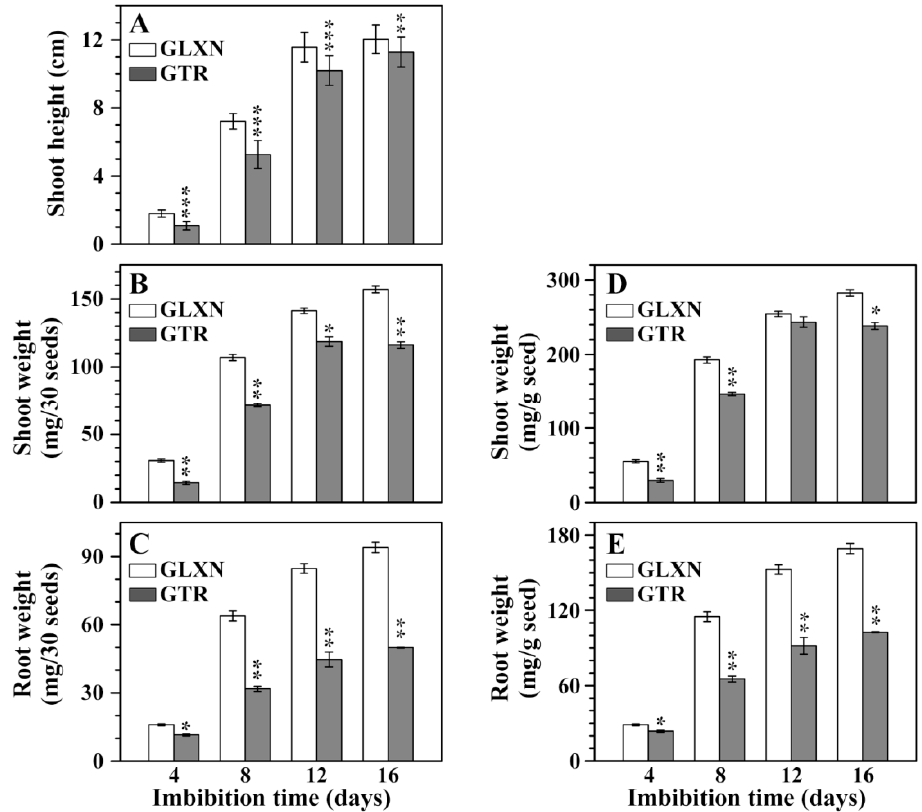
Figure 2. The shoot height ( A ), shoot dry weight ( B , D ), and root dry weight ( C , E ) of rice seedling. The values are means ± SD ( n = 3). * The GTR data are significantly different compared with the GLXN data at the same imbibition time (* for p < 0.05, ** for p < 0.01, and *** for p < 0.001).